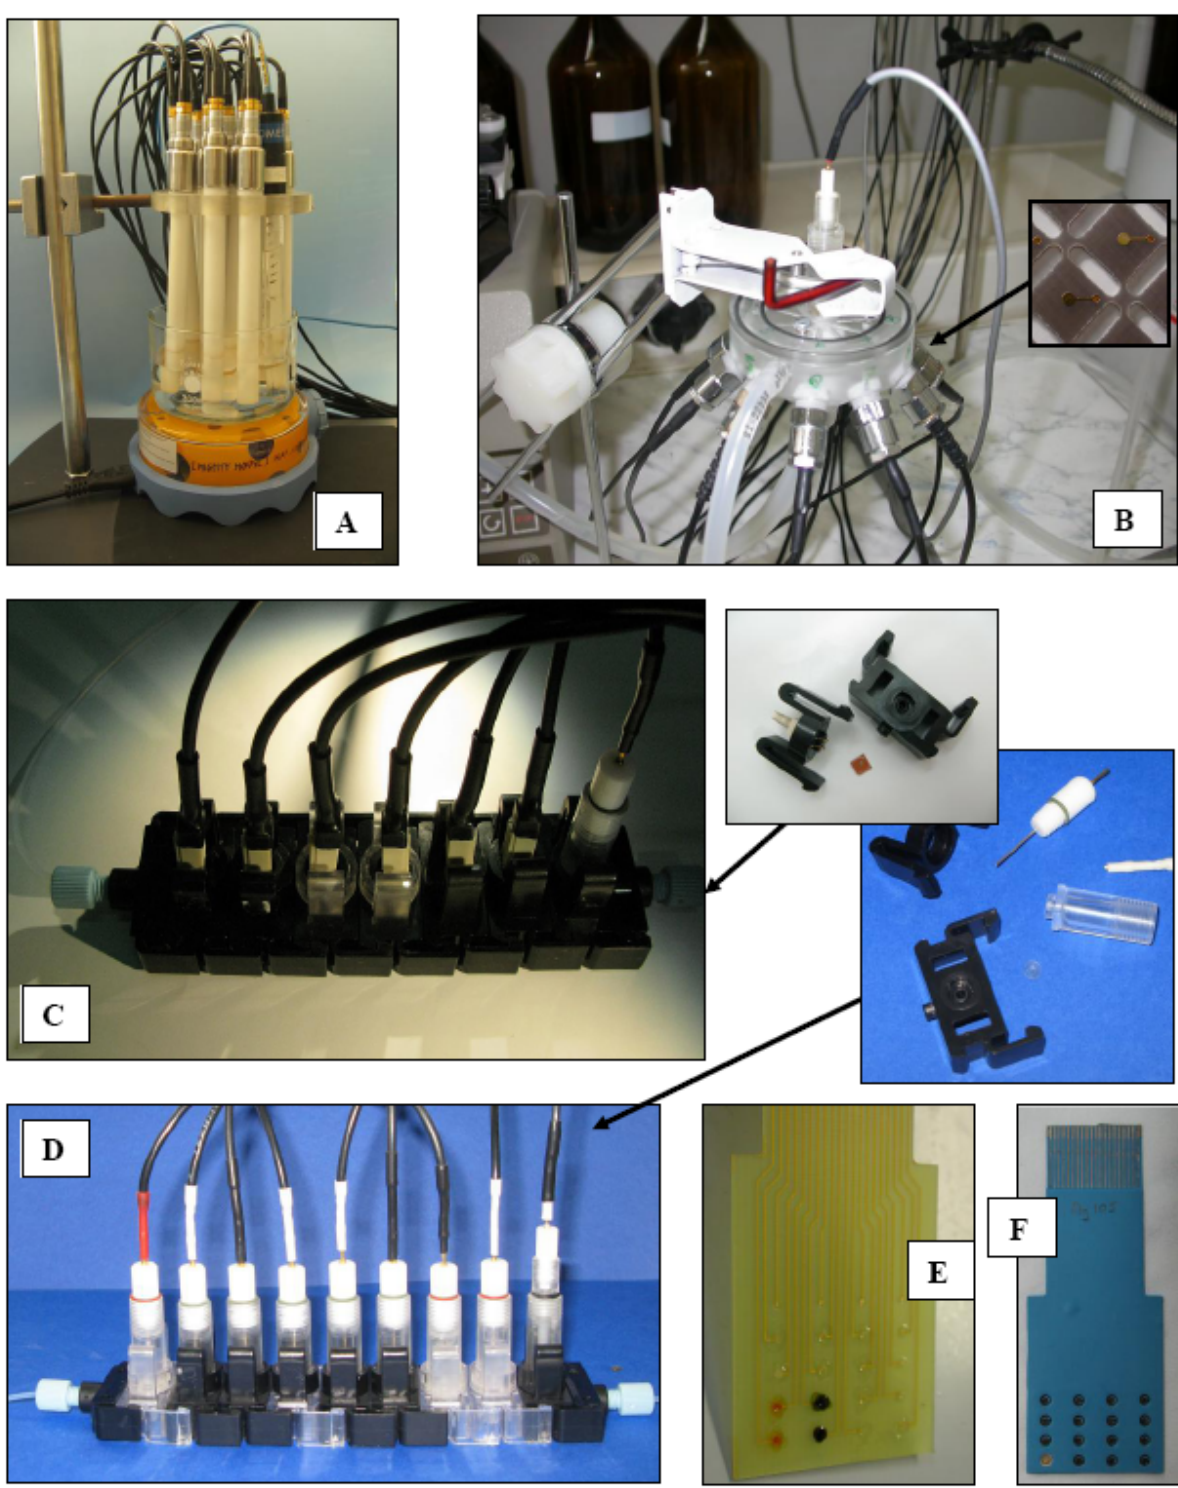
Figure 1. Sensor arrays composed of potentiometric electrodes ( A ) ISEs in Philips bodies ( B ) flow-through system with circular measurement cell and miniaturized SSEs ( C ), ( D ) linear flow-through systems with ( C ) SSEs ( D ) miniaturized ISEs with classical architecture ( E ), ( F ) integrated microelectrode arrays based on ( E ) epoxy-glass laminate ( F )